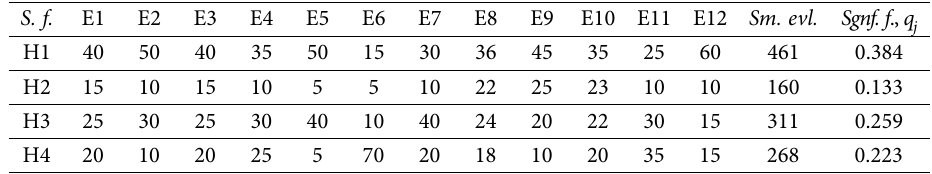
Table 21. The significance of factors in the group of circumstances relating to inventors regarding the commercial potential of technologies S. f.